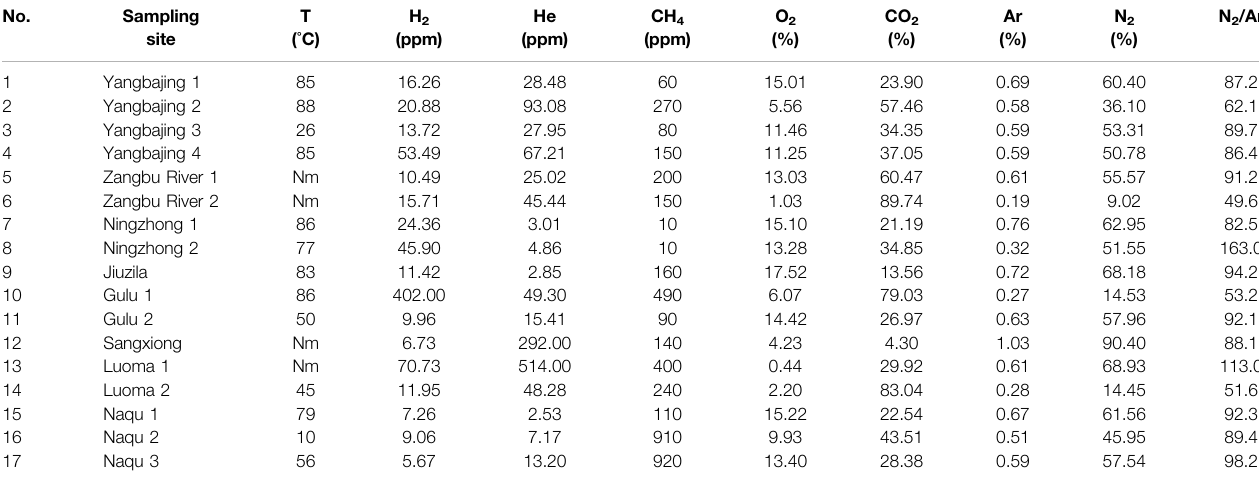
TABLE 1 | Chemical composition of hot spring gases in the northern Yadong-Gulu rift.